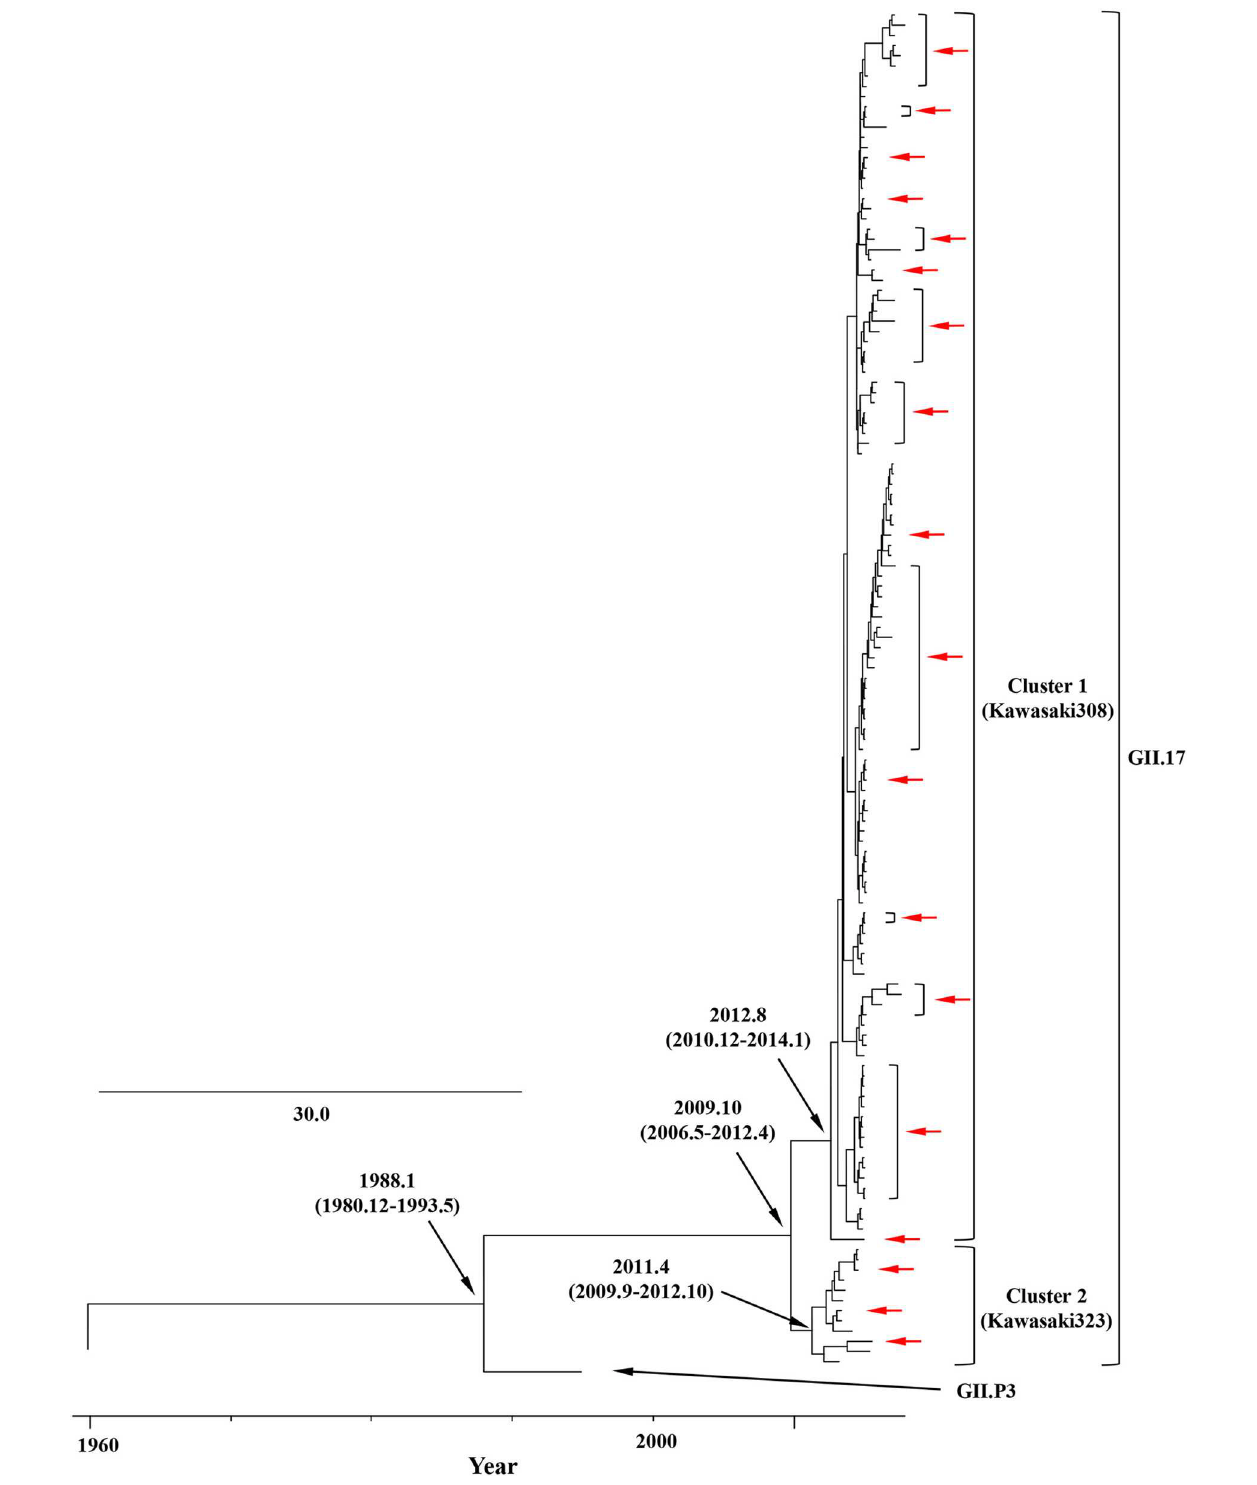
FIGURE 2 | Time-scaled phylogenetic trees of the full-length RdRp region of HuNoV constructed using the Bayesian MCMC inference. The tree visualization is enlarged to focus on GII.P17 and GII.P3. The values within parentheses indicate the 95% HPDs for each divergent year, and red arrows indicate the Japanese samples collected in this